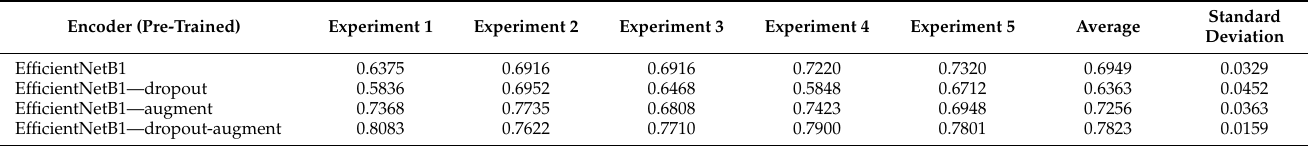
Table 4. Accuracy results of applying dropout and augmentation on the validation set.